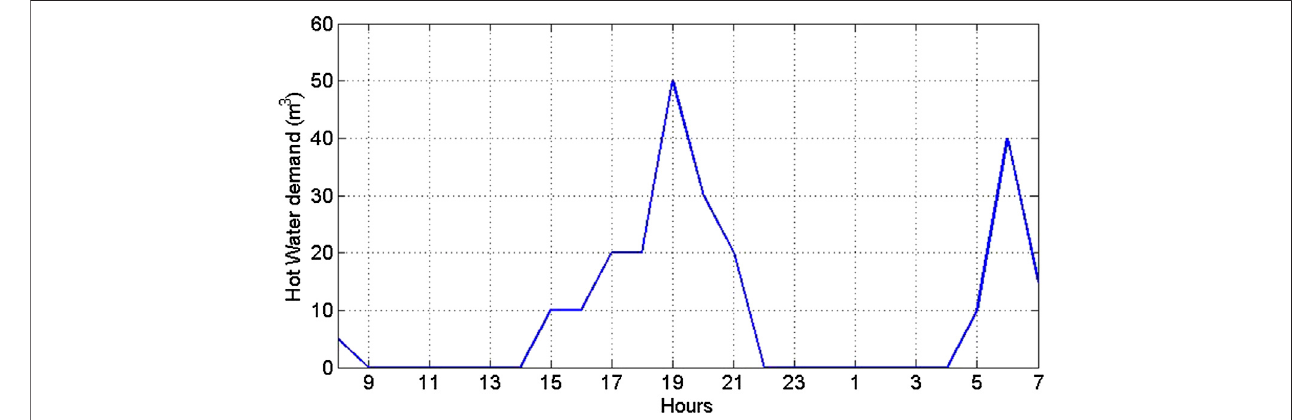
FIGURE 2 | Hot water demand.